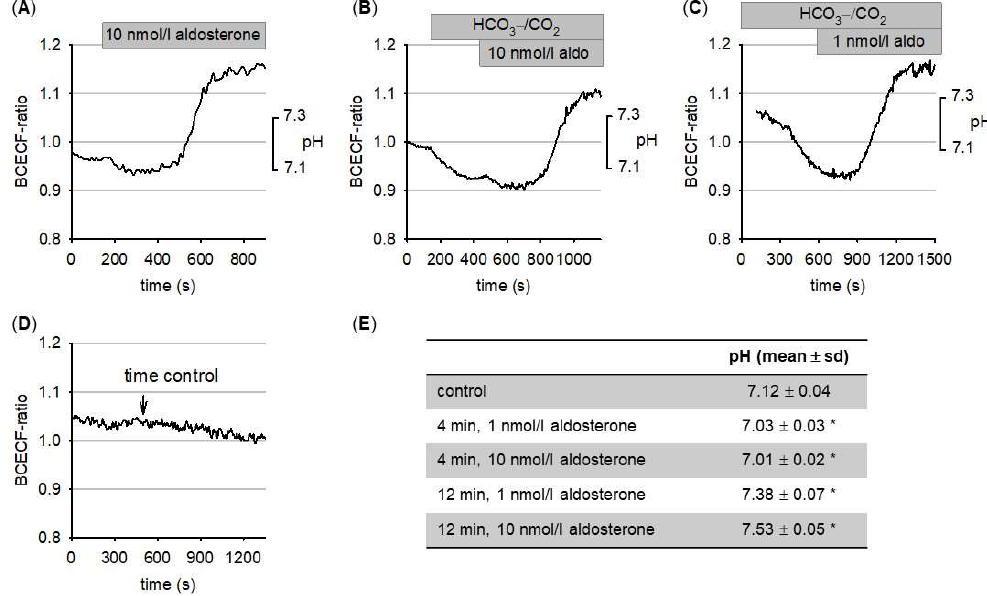
Figure 1. (A ) Aldosterone induces a rapid and biphasic change in cytosolic pH. Transient acidification is followed by sustained alkalinization. ( B ) Aldosterone-induced pH-changes are also observed in HCO 3− /CO 2 -buffered Ringer-solution. ( C ) pH-changes are also observed with 1 nmol/L aldosterone. ( D ) Time control experiments in HCO 3− /CO 2 -buffered Ringer-solution show that cytosolic pH does not increase under control conditions. ( E ) Summary of the pH-values before addition of aldosterone (control), during maximum acidification (4 min) and when the plateau of alkalinization was reached (12 min). N = 70–120 for each condition. * = p < 0.05 versus control.